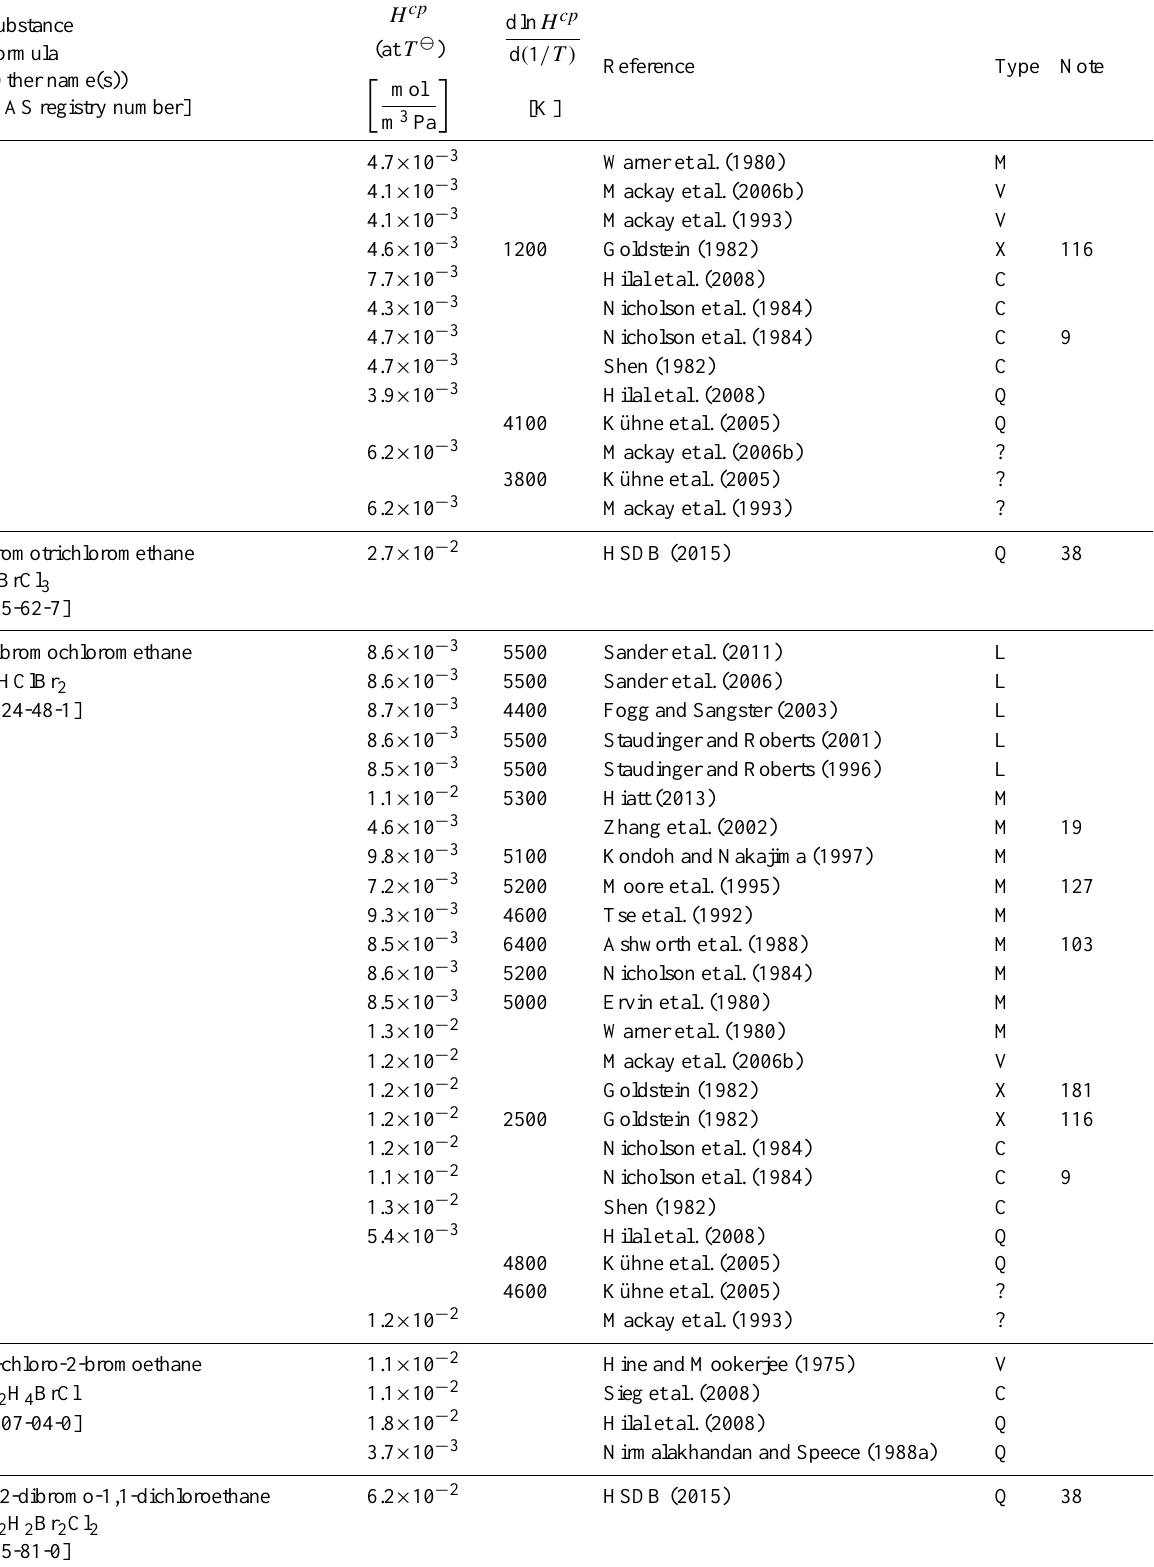
Table 6: Henry’s law constants for water as solvent